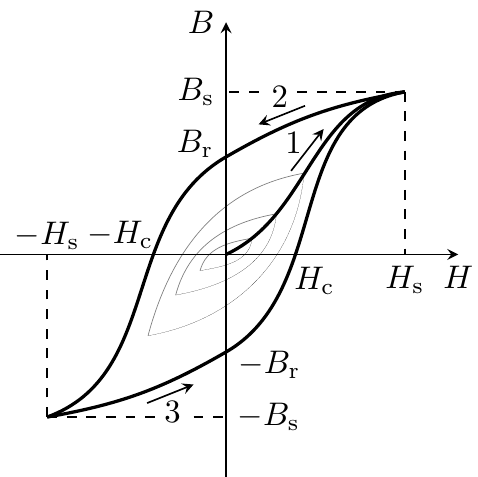
Figure 3. Schematic illustration of a hysteresis loop with the initial magnetization curve ( 1 ) , upper hysteresis curve ( 2 ) , lower hysteresis curve ( 3 ) , the saturation points magnetic parameters coercivity H c and residual magnetic flux density B r of the main loop and three inner Rayleigh loops.